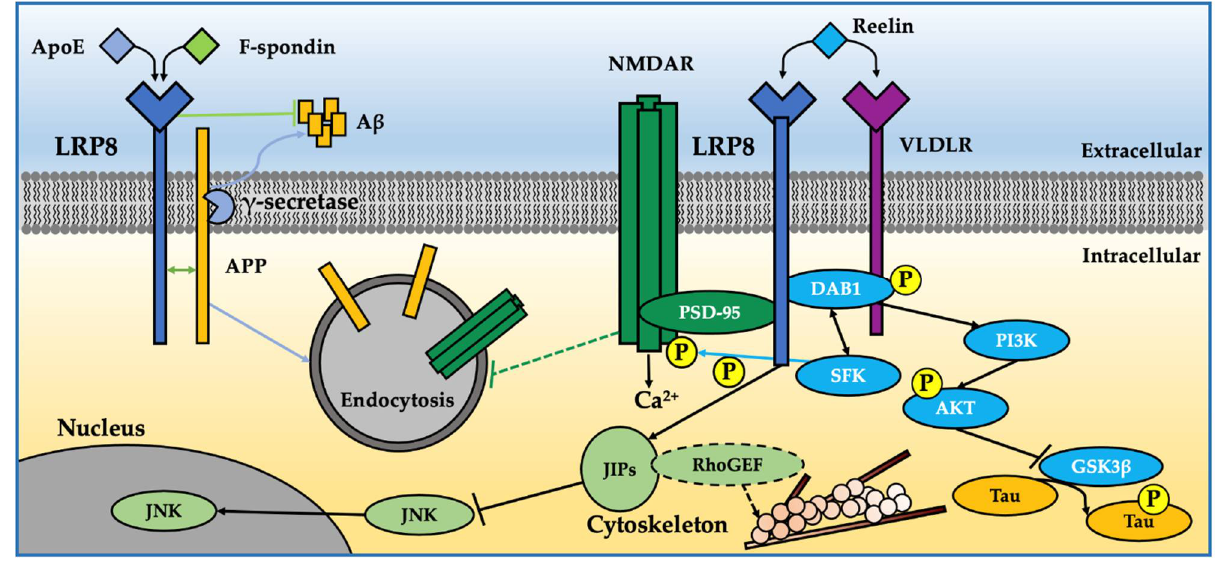
Figure 3. LRP8 in CNS related molecular pathways and neurodegeneration. Ligands binding to LRP8 modulate intracellular pathways, LRP8 cleavage, LRP8-APP interaction and Aβ production. (1) ApoE. Aβ production is increased by ApoE binding to LRP8 [157]. (2) F-Spondin. F-Spondin increases LRP8 cleavage and decreases Aβ production [158]. (3) LRP8 levels also modulate Aβ production in a positive manner by increasing the APP association with lipid rafts and γ-secretase activity [159]. (4) Reelin. Reelin binding to LRP8 induces different signaling pathways: (a) the tyrosin phosphorylation of Dab1 by Src-family kinases [160] and its interaction with the LRP8 NPxY motif. Phosphorylated Dab1 subsequently interacts with PI3K, whose activation leads to the further activation of Akt, which in turn inhibits GSK3β, suppressing tau phosphorylation [161]; (b) the LRP8-JIPS interaction at the plasma membrane level that interferes in turn with the signaling of JNK, whose translocation into the nucleus is therefore inhibited. In addition, the activity of rhoGEF, which is associated with JIP, might be modulated by the Reelin-LTP8-JIPs complex [18,162]; (c) the promotion of LRP8, Dab1 and NMDA-R clustering and related NMDA-R phosphorylation mediated by SFK, which in turn leads to an increase in calcium influx [163] (Chen, 2005). The signal activated by LRP8 and NMDA-R complex, but not necessarily their physical association, involves PSD-95, which is known to inhibit NMDA-R internalization [164].